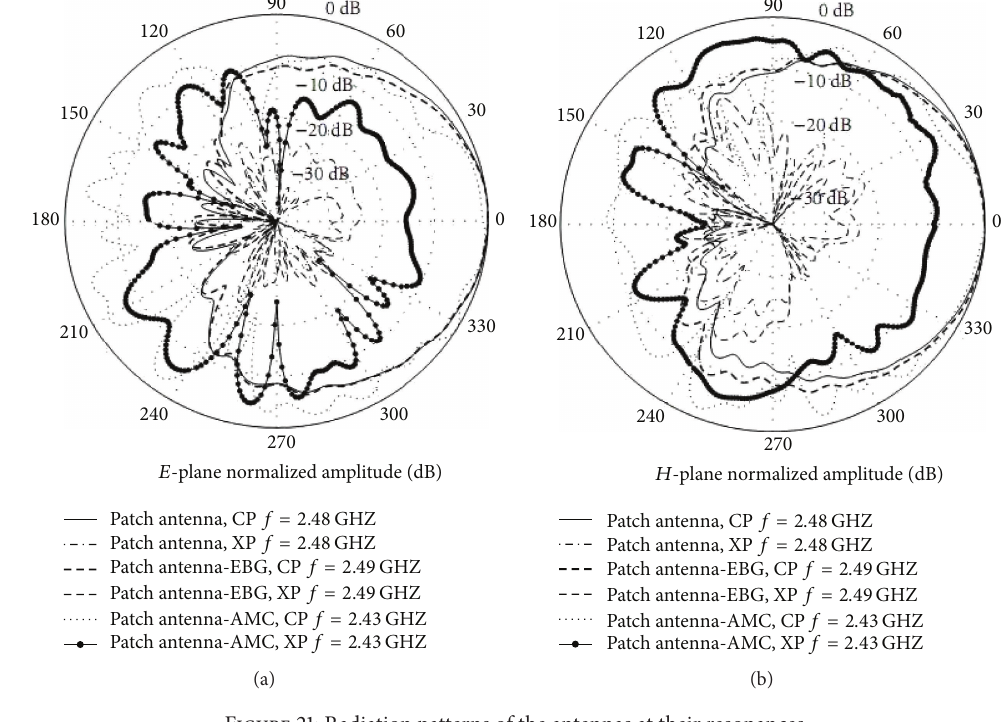
Figure 21: Radiation patterns of the antennas at their resonances.